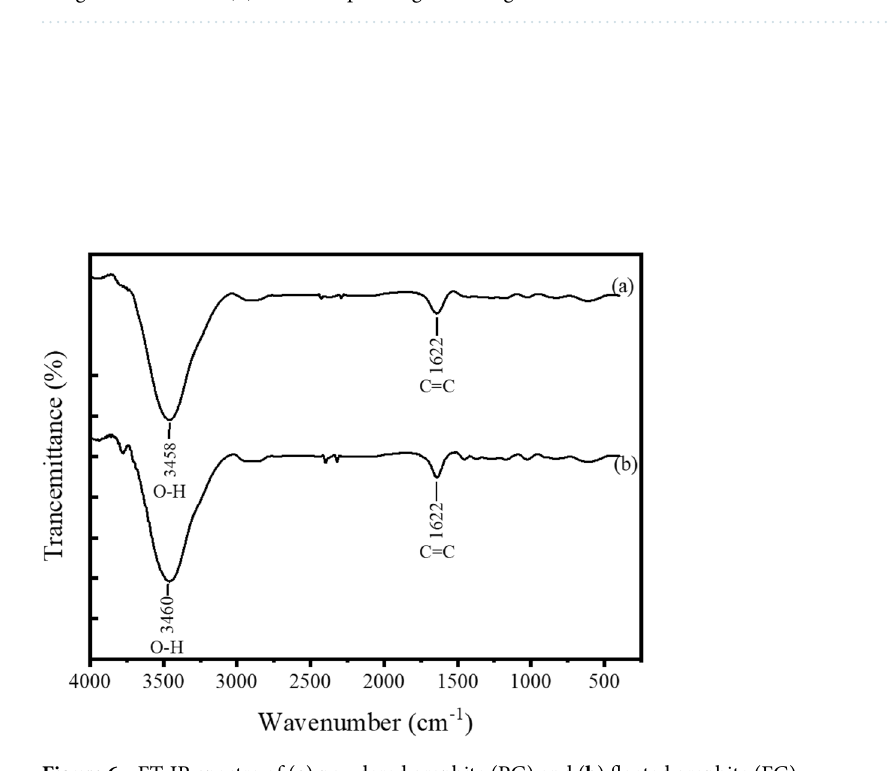
Figure 5. ( a ) Low-magnification bright-field TEM image of the FG specimen. The inset is the corresponding selected-area electron diffraction pattern showing the primarily single crystalline nature. ( b ) High resolution TEM image of the edge of the flakes consisting approximately 16 layers. ( c ) Fourier filtered high resolution TEM image of the FG and ( d ) the corresponding FFT image.